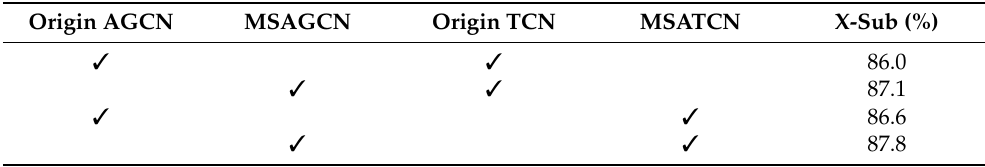
Table 2. Recognition accuracy with different combination of MSAGCN and MSATCN on the NTU RGB+D X-sub benchmarks.